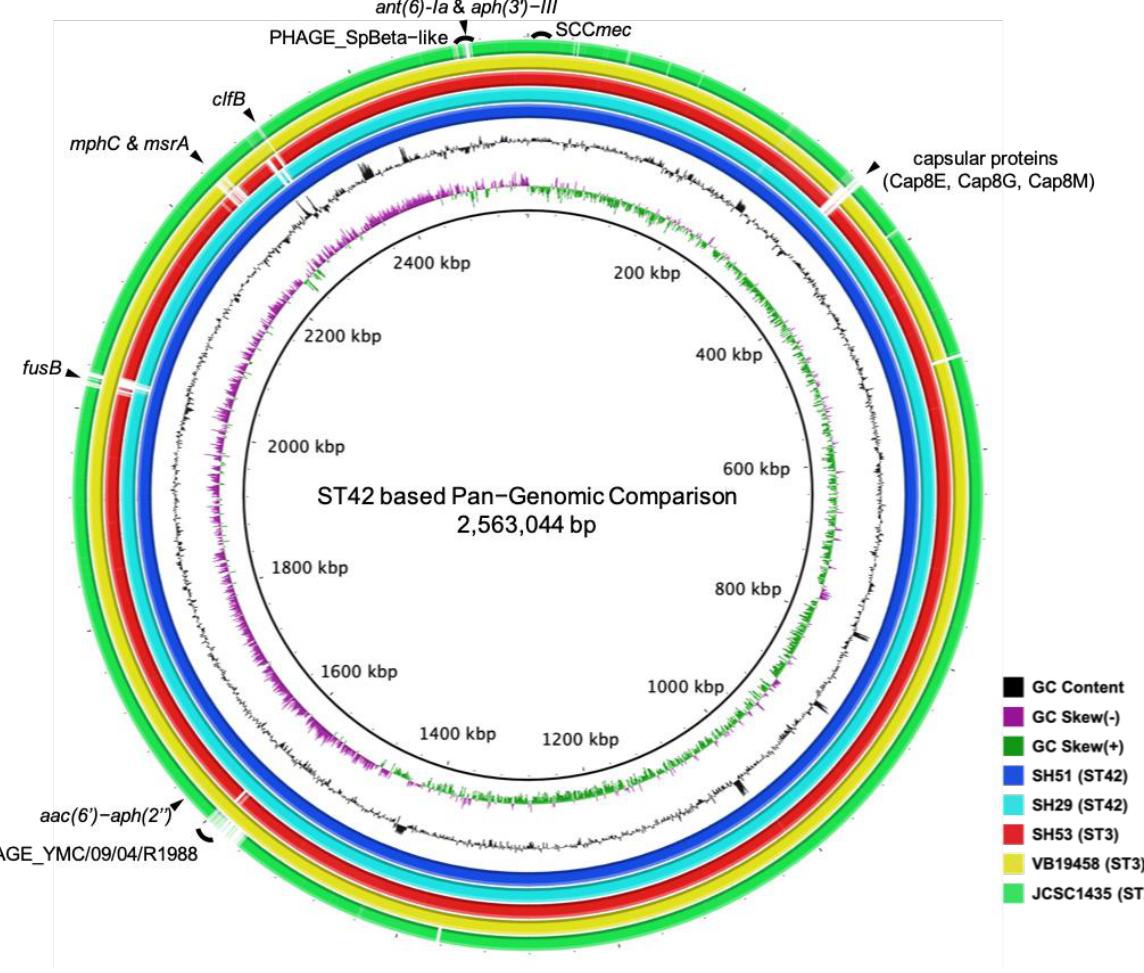
Figure 1. Comparative genomic analysis of genome structure of CGMH-SH51, CGMH-SH53, and the three reference strains. Table 1. General information of WGS analysis of five S. haemolyticus strains.